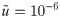
Dispersal promotes soft sweep detection in small subranges.(a)–(c) Probability of observing a hard sweep in j samples randomly chosen from contiguous subranges of different sizes Ls in simulated 1D ranges of size L = 106, with rescaled mutation rate u˜=10-6. At the same mutation rate, broader dispersal kernels lead to a larger average clone size (〈X〉 ≈ 980, 1.6 × 104, 4 × 104 for μ = {4, 1, 0.6} respectively), which reduces the total number of alleles and favours hard sweep signatures when the sampling is done over the entire range [L = Ls, (a)]. However, when Ls is reduced [(b)–(c)], the detection of soft sweeps become increasingly likely for the broader dispersal kernels; the broken-up structure of clones compensates for their smaller overall number. For small enough subranges, the order of values of Phard(j) with increasing μ is inverted compared to the values at Ls = L.